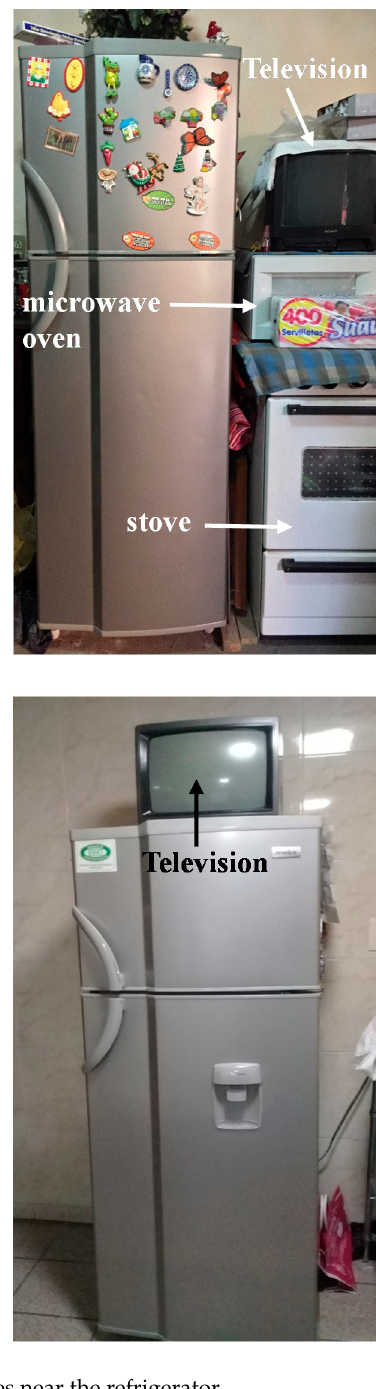
Figure 13. Typical examples of heat sources near the refrigerator.